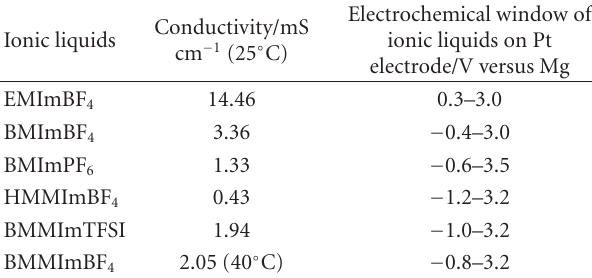
Table 1: Conductivity and electrochemical window of the imidazolium-based ILs used in this